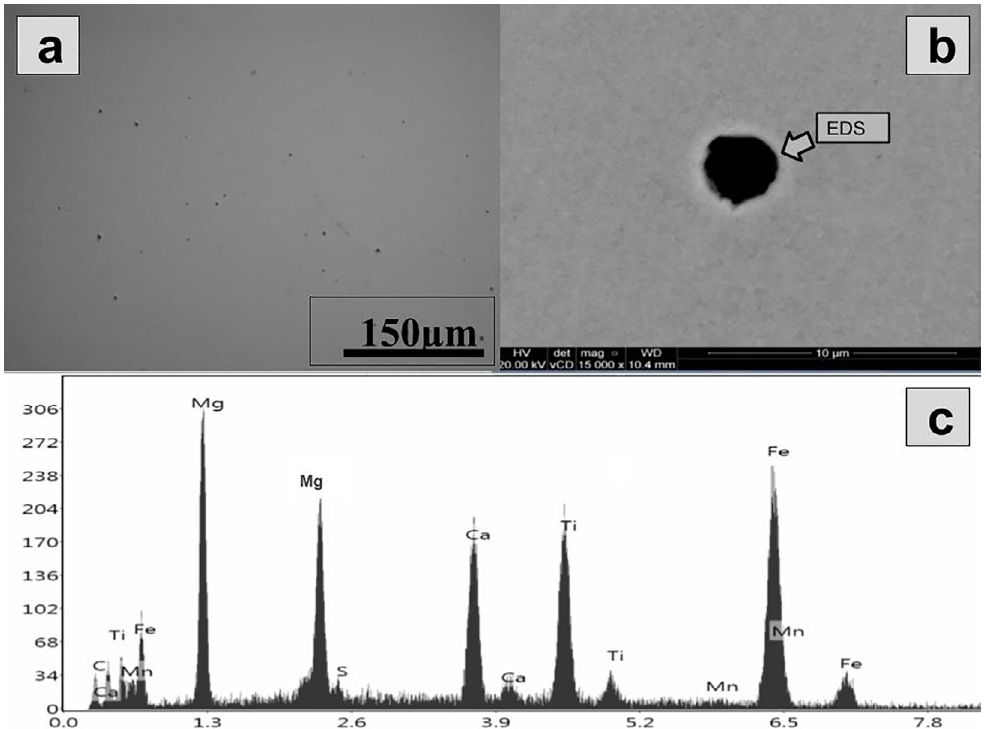
Figure 1. Optical microscopy image of the inclusions distribution in the microstructure of the API 5L X65 steel (a), representative EDS spectrum of the inclusions (b), and backscattered SEM image of a round-shaped inclusion (insert in